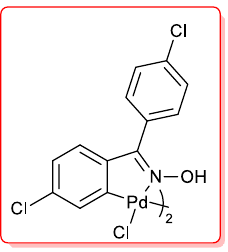
Figure 3. Palladacycle catalysts for acylation of terminal alkynes.